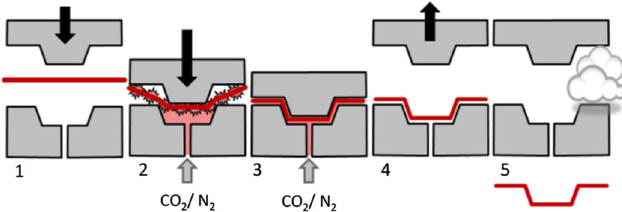
Fig. 1. Sketch of the forming process using volatile fl uids as lubricant.